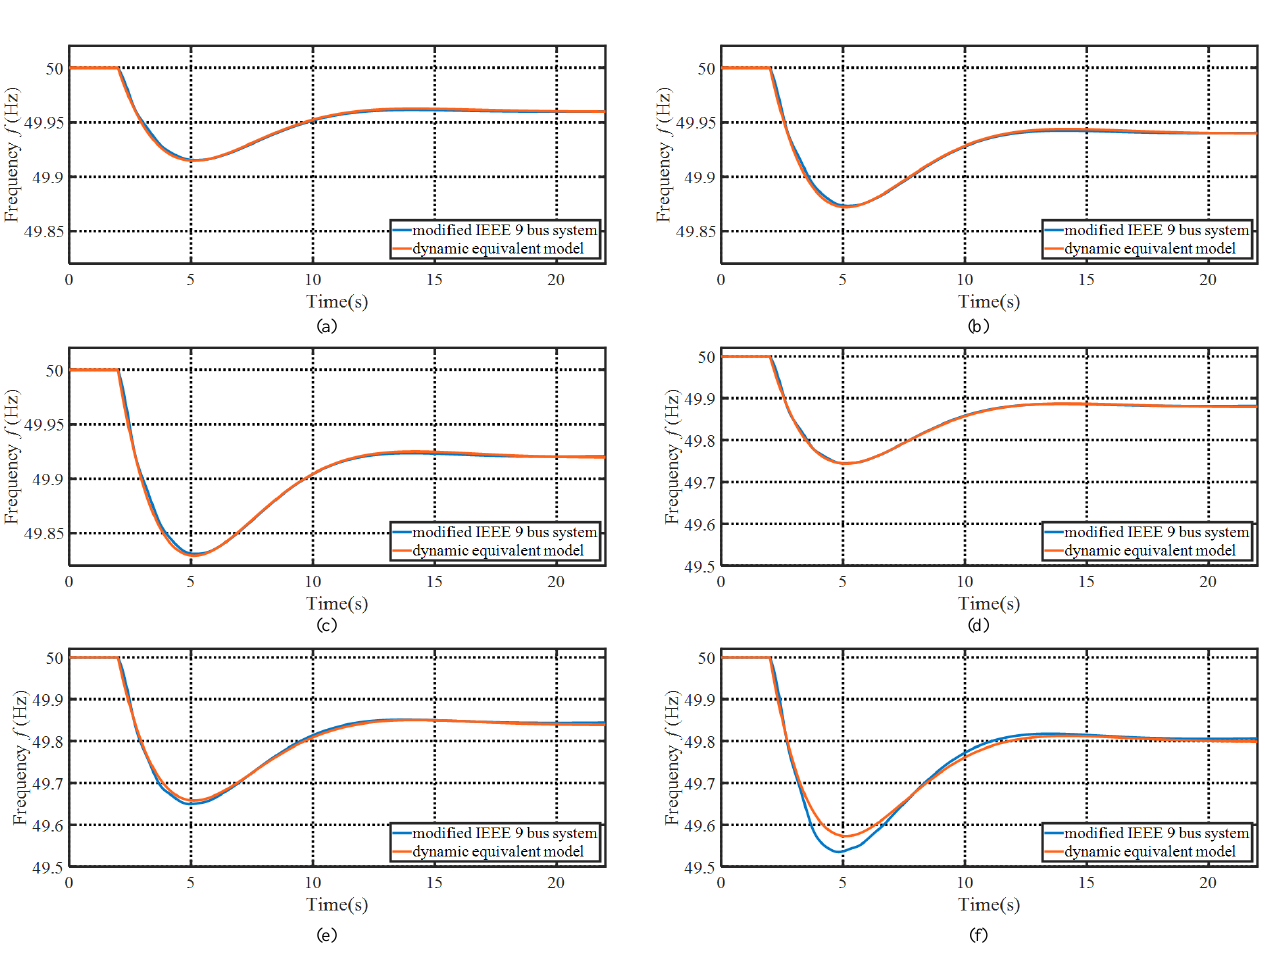
Figure 18. Frequency dynamics of the IEEE 9-bus system and dynamic equivalent model under dif- ferent load disturbance ∆ P d . ( a ) ∆ P d = − 2%, ( b ) ∆ P d = − 3%, ( c ) ∆ P d = − 4%, ( d ) ∆ P d = − 6%, ( e ) ∆ P d = − 8%, and ( f ) ∆ P d = −